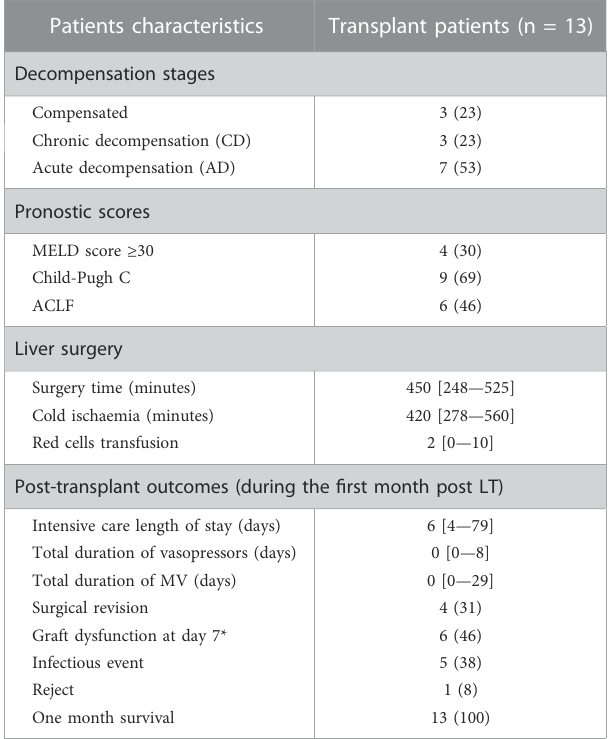
TABLE 2 Characteristics of transplanted patients.